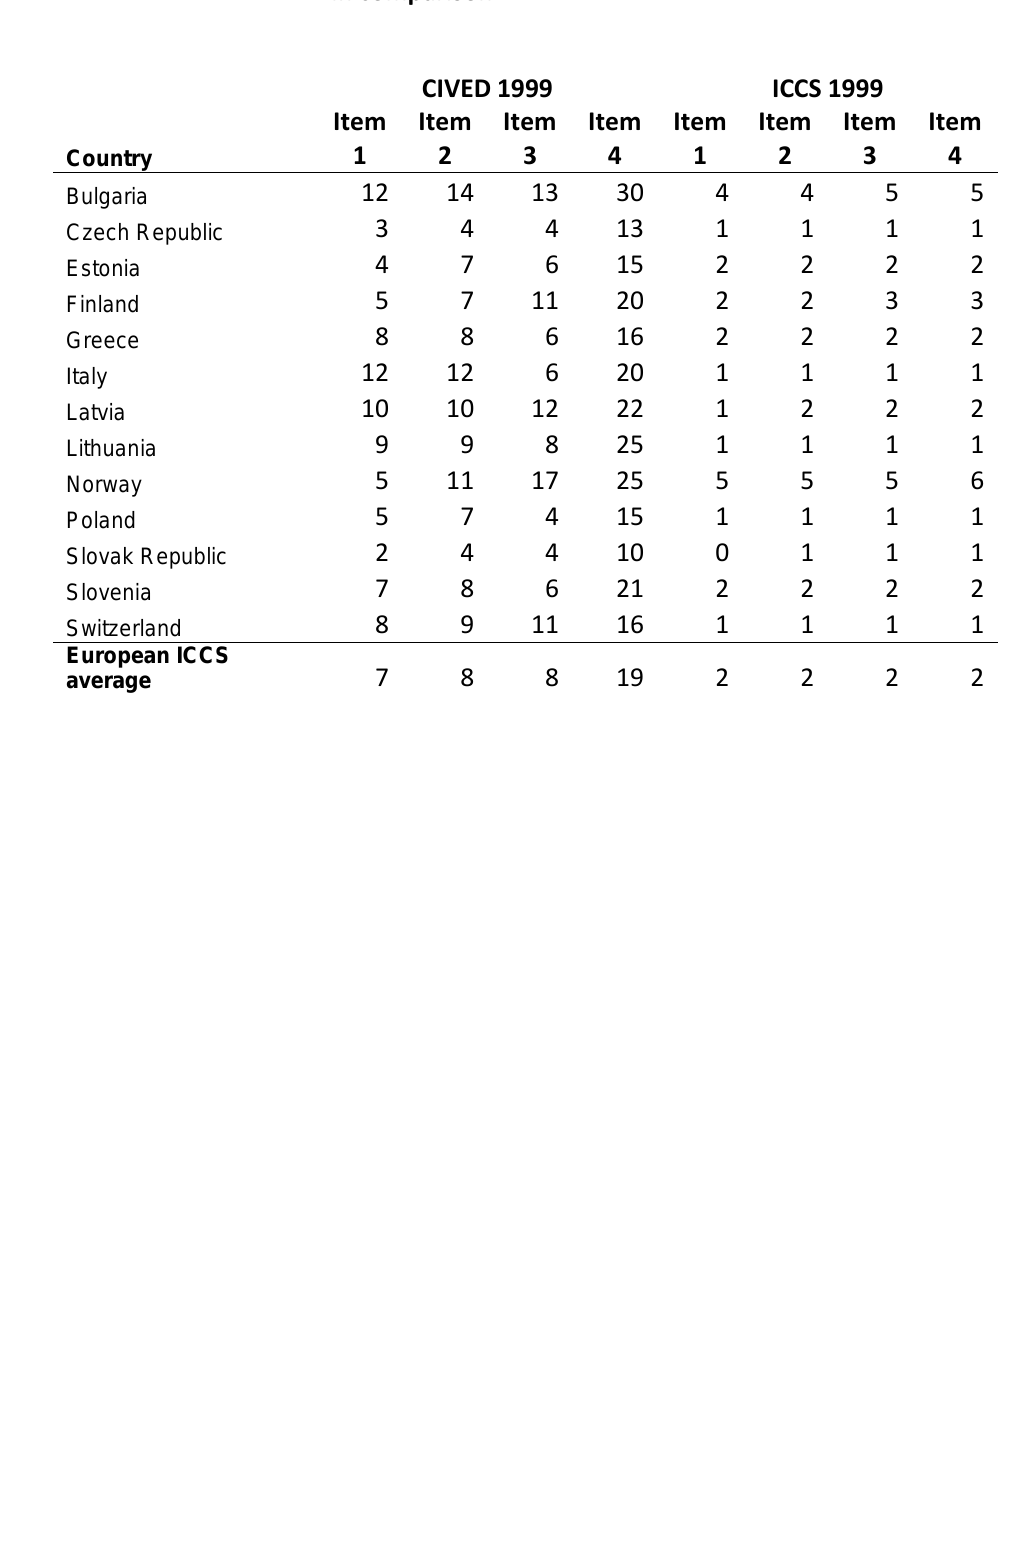
Table 7 Percentages of missing responses for ethnic group